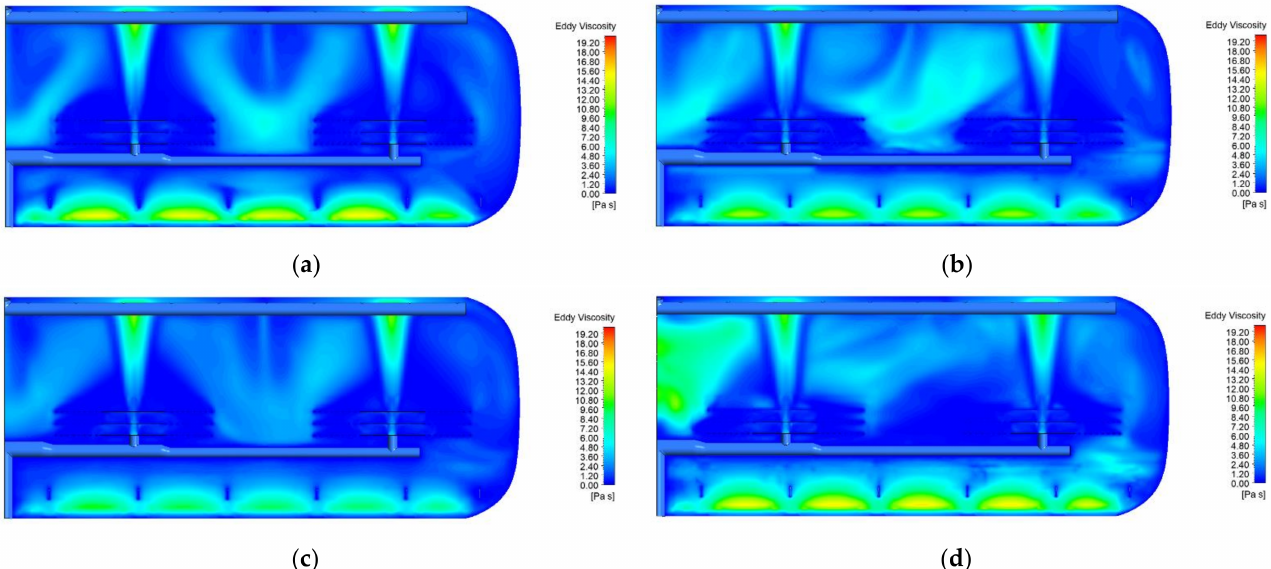
Figure 7. Effect of the water content on the Eddy viscosity in a longitudinal plane for ( a ) high water content, experiment 9 (D = 1 µ m, µ = 0.017 kg/ms, x = 0.12, and E = 0.1 kV/cm); ( b ) low water content, experiment 1 (D = 1 µ m, µ = 0.017 kg/ms, x = 0.03, and E = 0.1 kV/cm). Effect of the electric field on the Eddy viscosity in a longitudinal plane for ( c ) high electric field, experiment 11 (D = 1 µ m, µ = 0.071 Kg/ms, x = 0.12, and E = 3 kV/cm); ( d ) low electric field, experiment 15 (D = 1 µ m, µ = 0.071 Kg/ms, x = 0.12, and E = 0.1